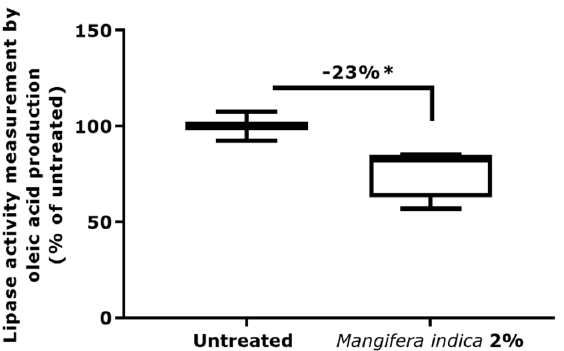
Figure 7. Measurement of lipase activity of representative severe acneic strain of C. acnes phylotype IA1 using oleic acid quantification in presence of M. indica extract at 2%. Significance with * p < 0.05.